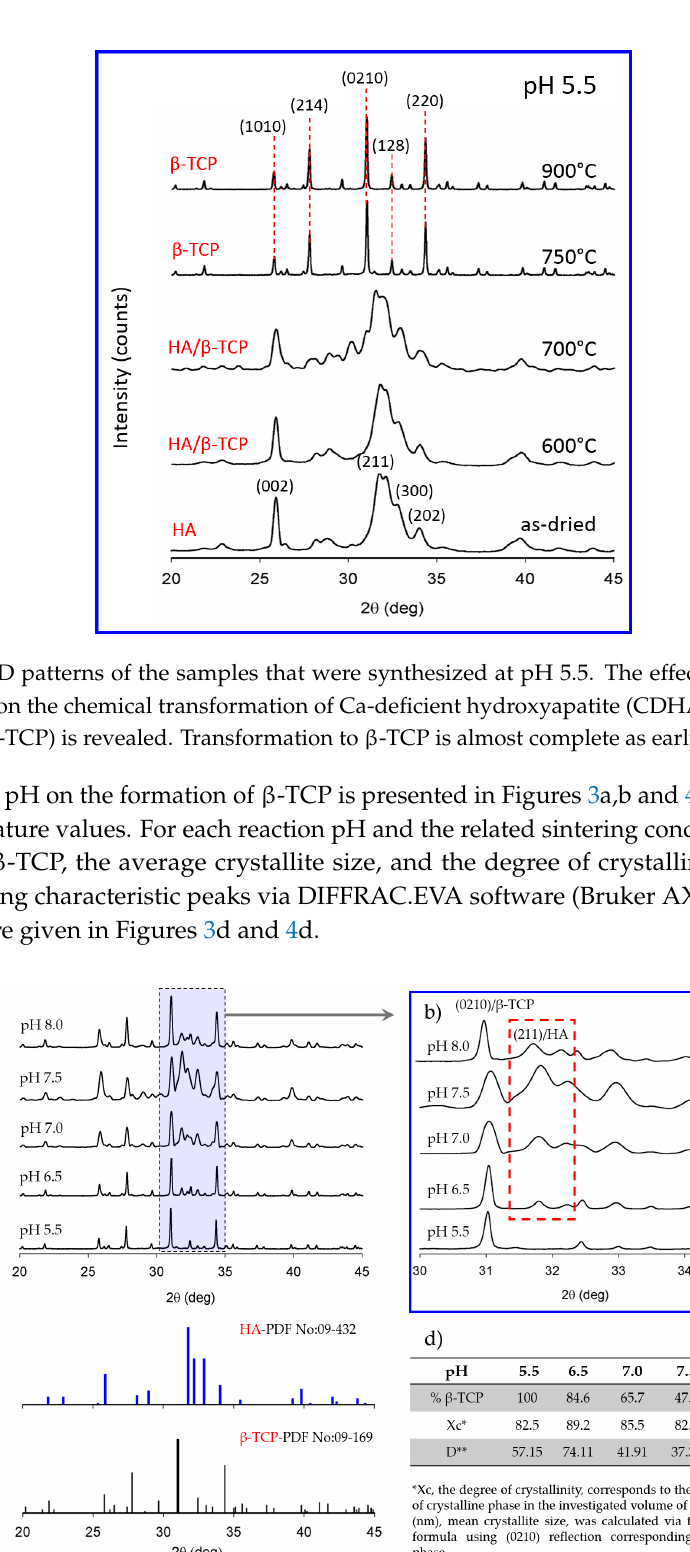
Figure 3. XRD results of the samples that were sintered at 750 °C: ( a ) For the range of 20–45°; ( b ) for the range of 30–35°; ( c ) XRD pattern of standard HA (No:09-0432) and β -TCP (No: 09-0169); ( d ) calculated percentage of transformed β -TCP, average crystallite size, and the degree of crystallinity. The effect of sintering temperature on the chemical transformation of CDHA to β -TCP is revealed. Transformation to β -TCP is completed as early as 750 ◦ C for the sample that was synthesized under pH